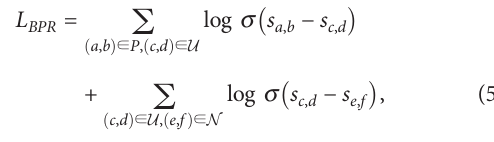
TABLE 1 | Number of labeled training samples for each cell